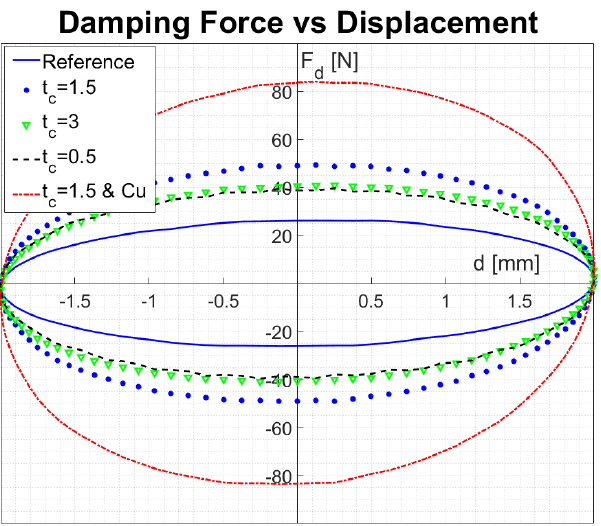
Figure 15. Influence of the damping force on the EC damper from ref. [1] with the contribution of back iron.